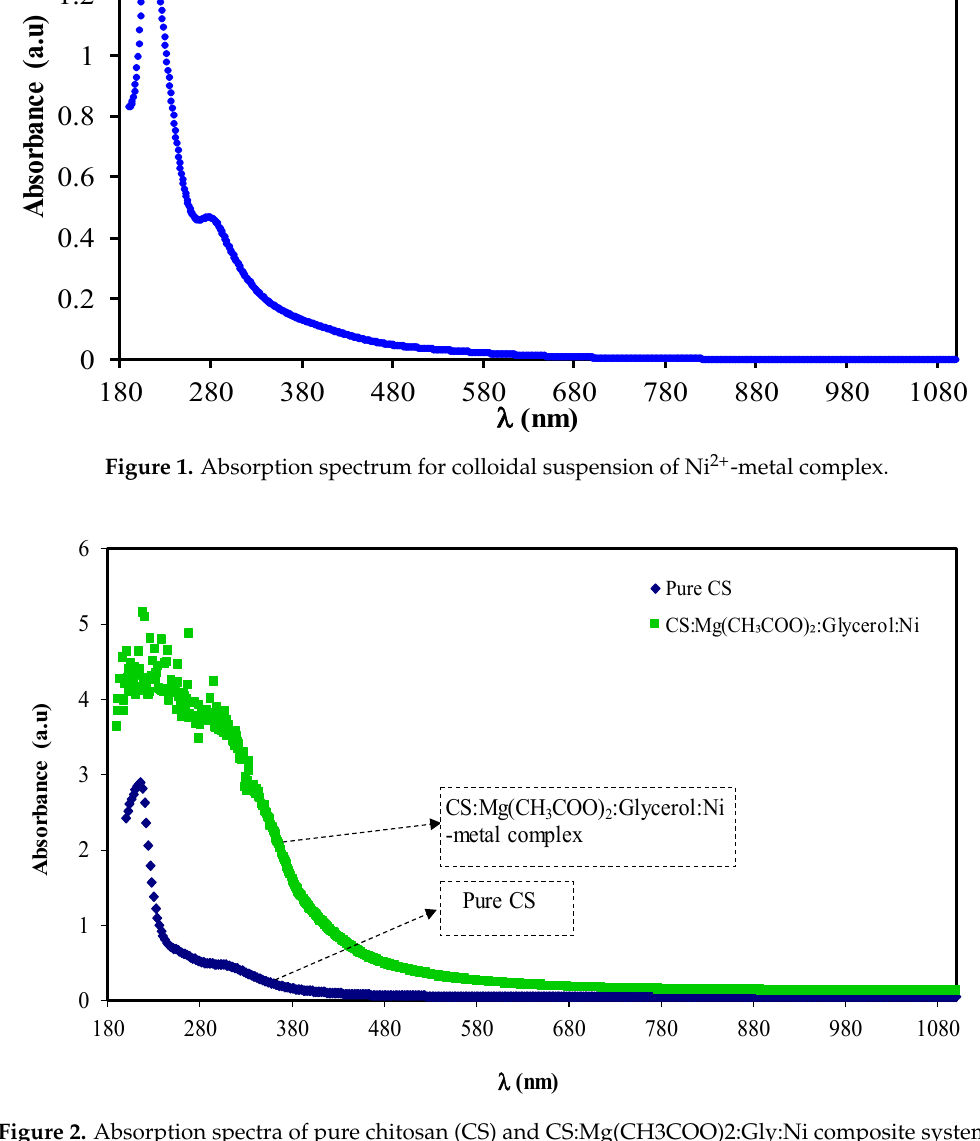
Figure 2. Absorption spectra of pure chitosan (CS) and CS:Mg(CH3COO)2:Gly:Ni composite system.